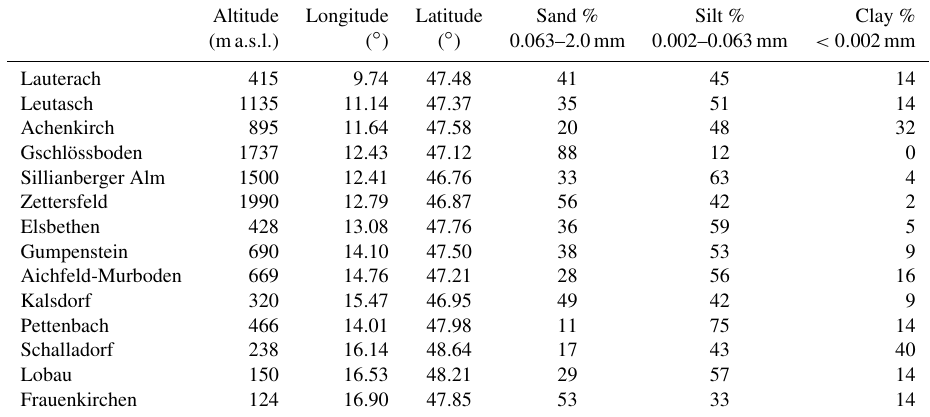
Table A1. Site properties and particle size distribution of the upper soil layer (ÖNORM L 1050,